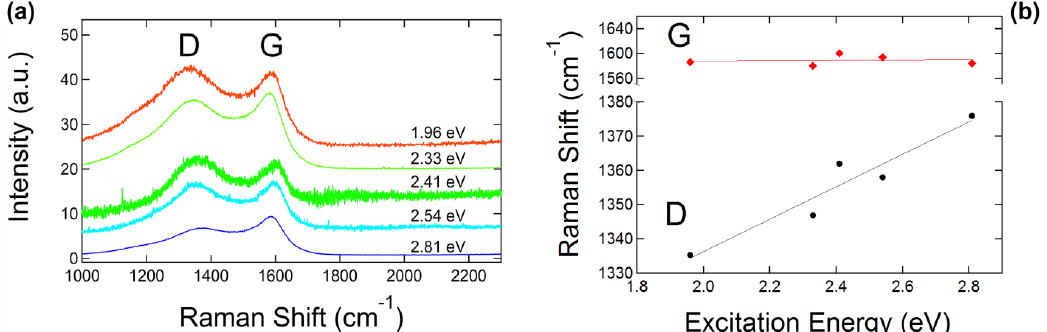
Figure 4. ( a ) The Raman spectra of GUITAR for a variety of excitation energies showing the prominent D and G peaks, and ( b ) the positions of the D and G peaks plotted as a function of excitation energy.